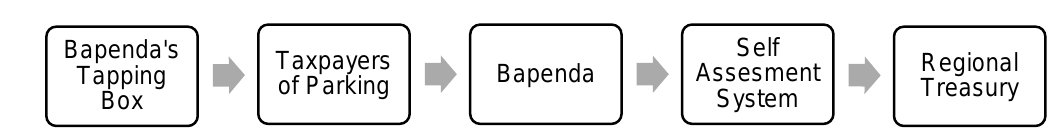
Figure 1. Flow of Parking Tax Collection by Using Tapping